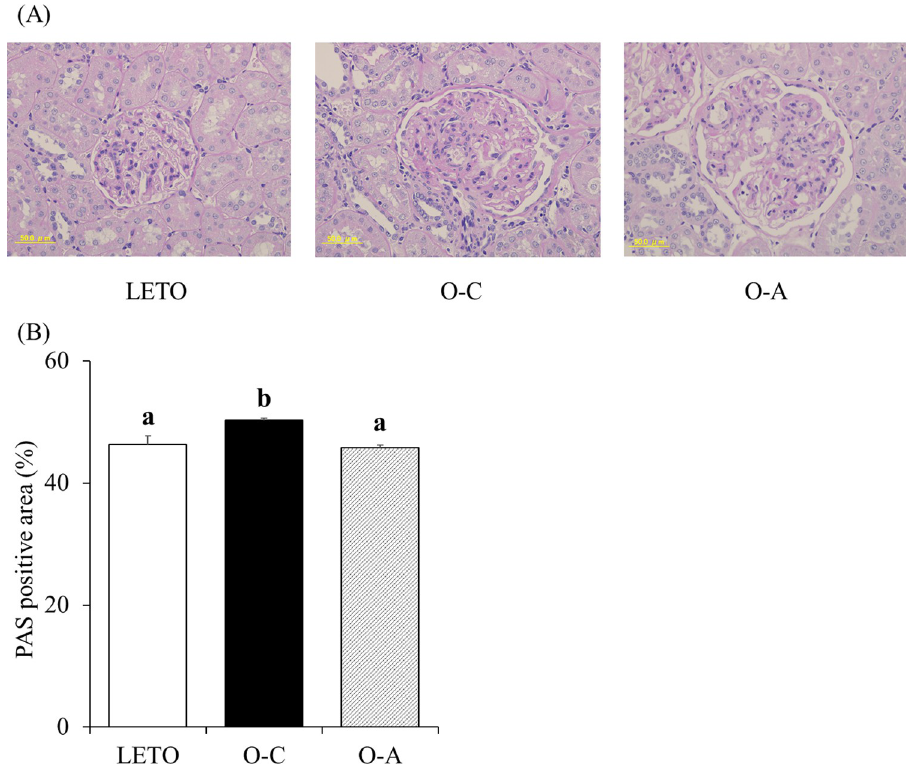
Fig 2. Histological analyses of kidneys in LETO and OLETF rats. (A) Kidney histological sections by the periodic acid-Schiff (PAS) stains (400 × ). (B) PAS-positive area within the total glomerular area. The data are presented as mean ± standard error (SE) (n = 10 for OLETF rats and n = 6 for LETO rats). ab Different letters in the same column indicate statistical difference, P < 0.05, Tukey’s multiple comparison test. PAS, periodic acid-Schiff; LETO, Long- Evans Tokushima Otsuka; OLETF, Otsuka Long-Evans Tokushima fatty; O-C, OLETF control; O-A, OLETF D - allulose.